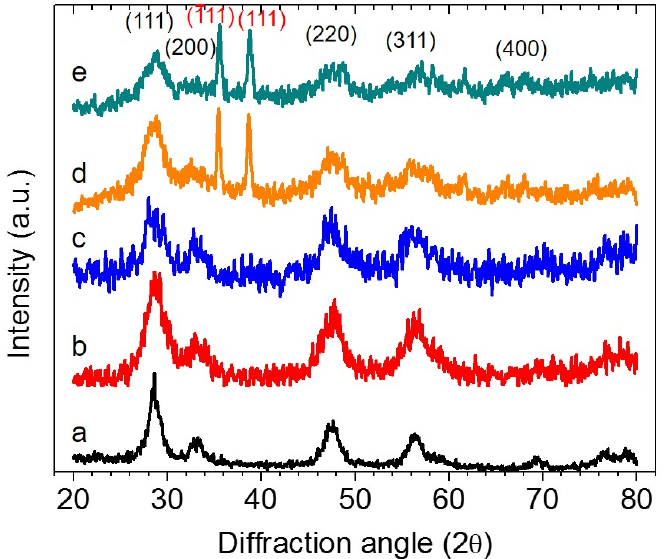
Figure 2. X-ray diffraction (XRD) patterns of mesoporous ( a ) mp -CeO 2 ; ( b ) CuO(16)/CeO 2 ; ( c ) CuO(26)/CeO 2 ; ( d ) CuO(38)/CeO 2 and ( e ) CuO(45)/CeO 2